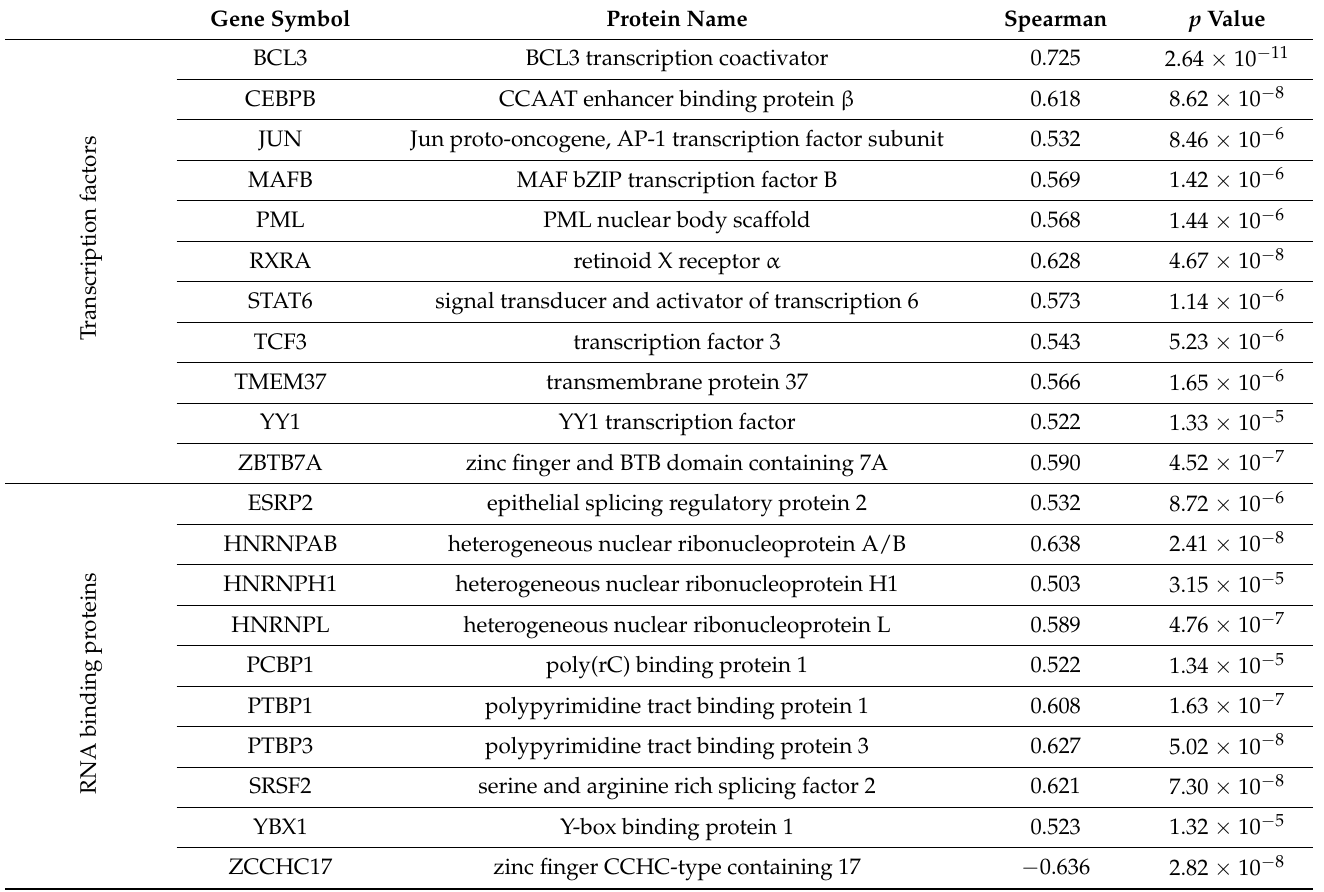
Table 2. Transcription factors and RNA binding proteins with a significant correlation with NAPRT expression. Gene Symbol Protein